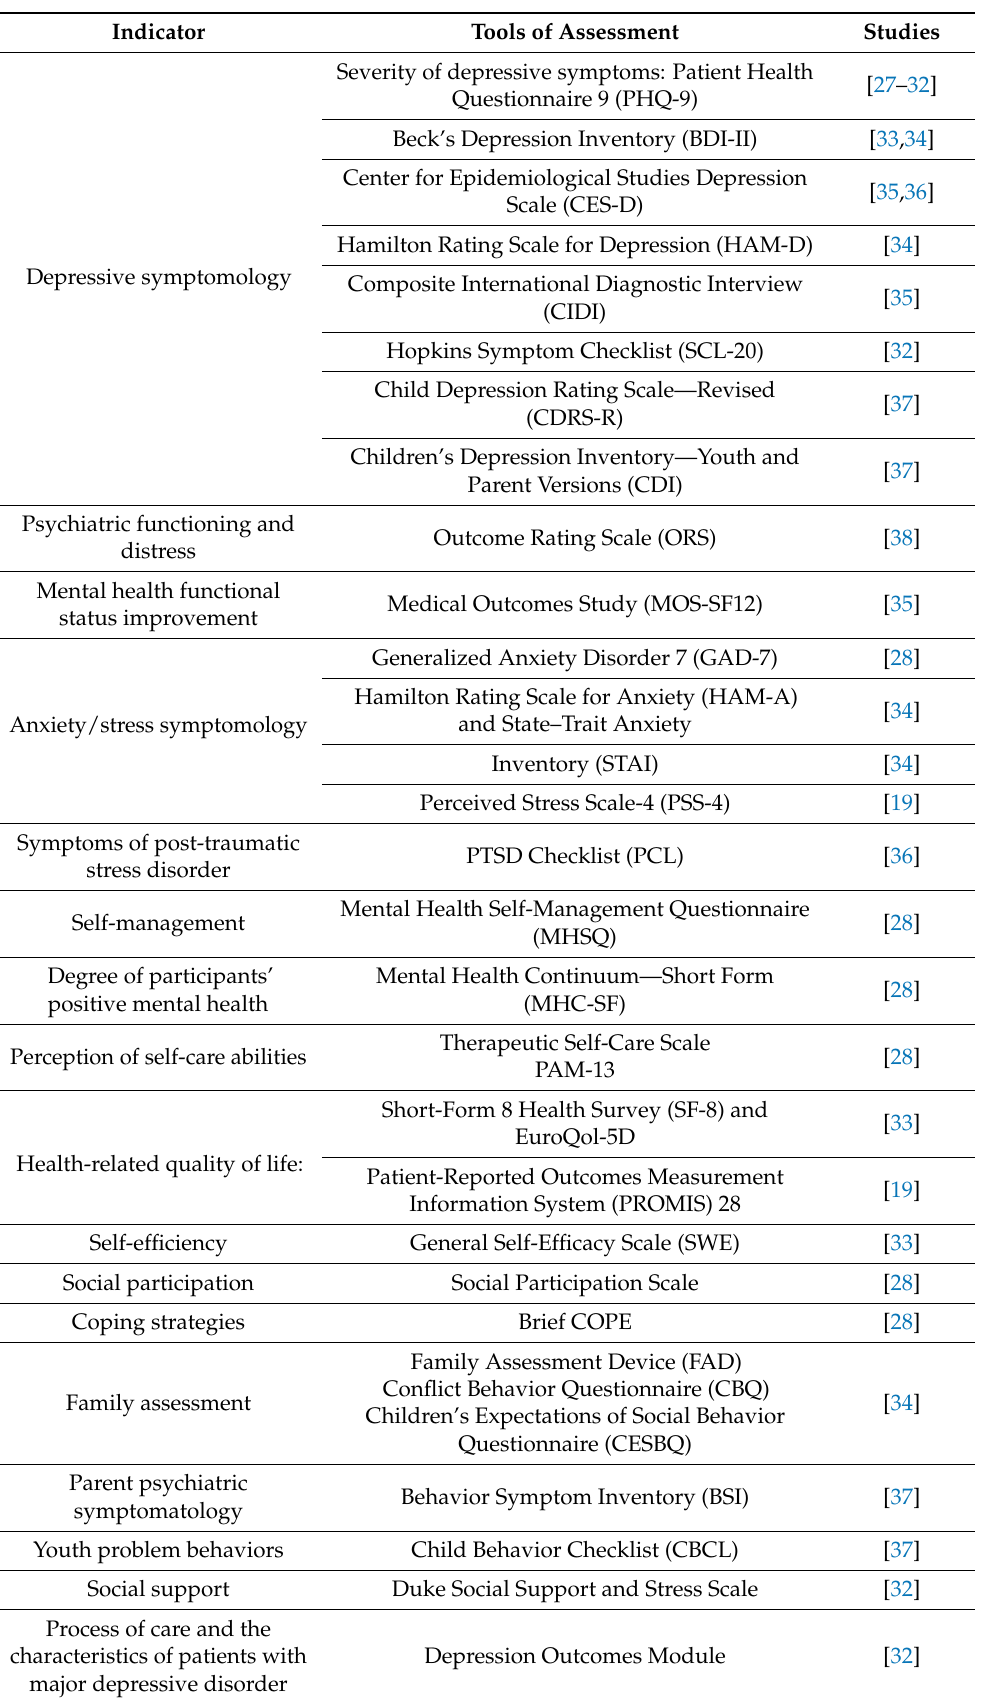
Table 1. Patient assessment indicators and assessment